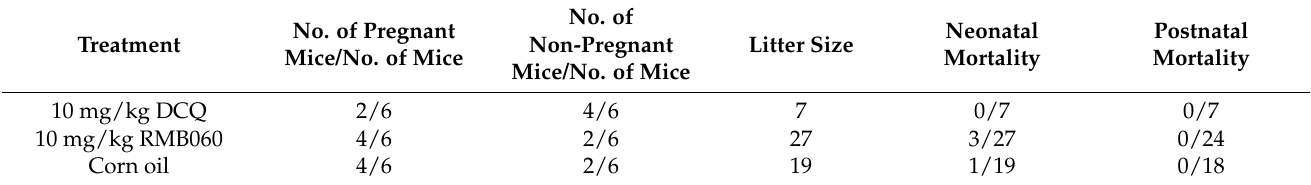
Table 3. Potential pregnancy interference of DCQ and RMB060 in embryo development.